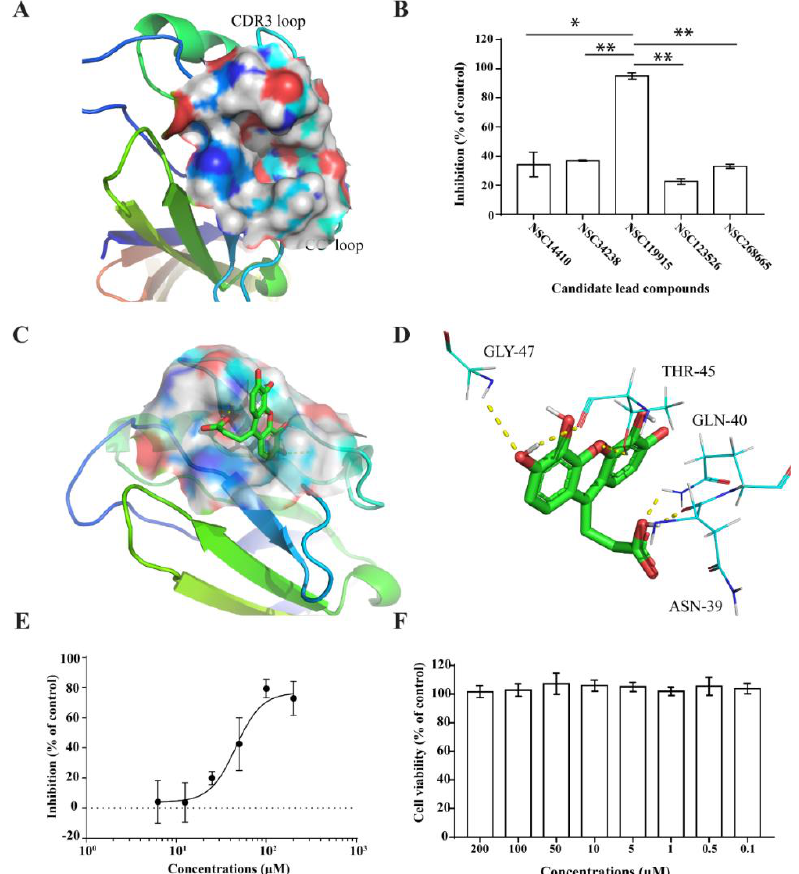
Figure 1. Binding pocket on CD4 surface ( A ) and compounds exhibited varying extents of inhibition of anti-human CD4 antibody binding to CD4 ( B ). The docking models of NSC119915 and CD4 receptor ( C ) and interaction of NSC119915 and CD4 ( D ). NSC119915 displayed dose-dependent inhibition ( E ) while not showing any cytotoxicity ( F ). * p value < 0.05, ** p value < 0.005.